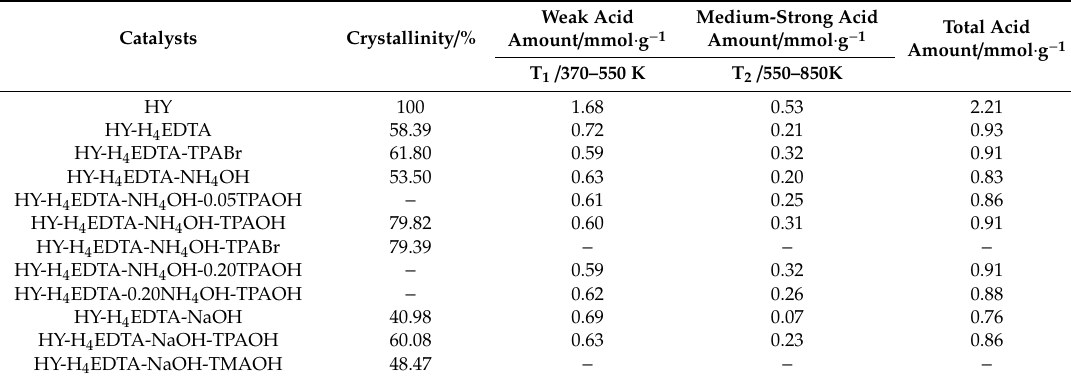
Table 1. The crystallinity and acidity distribution of pretreated zeolites.